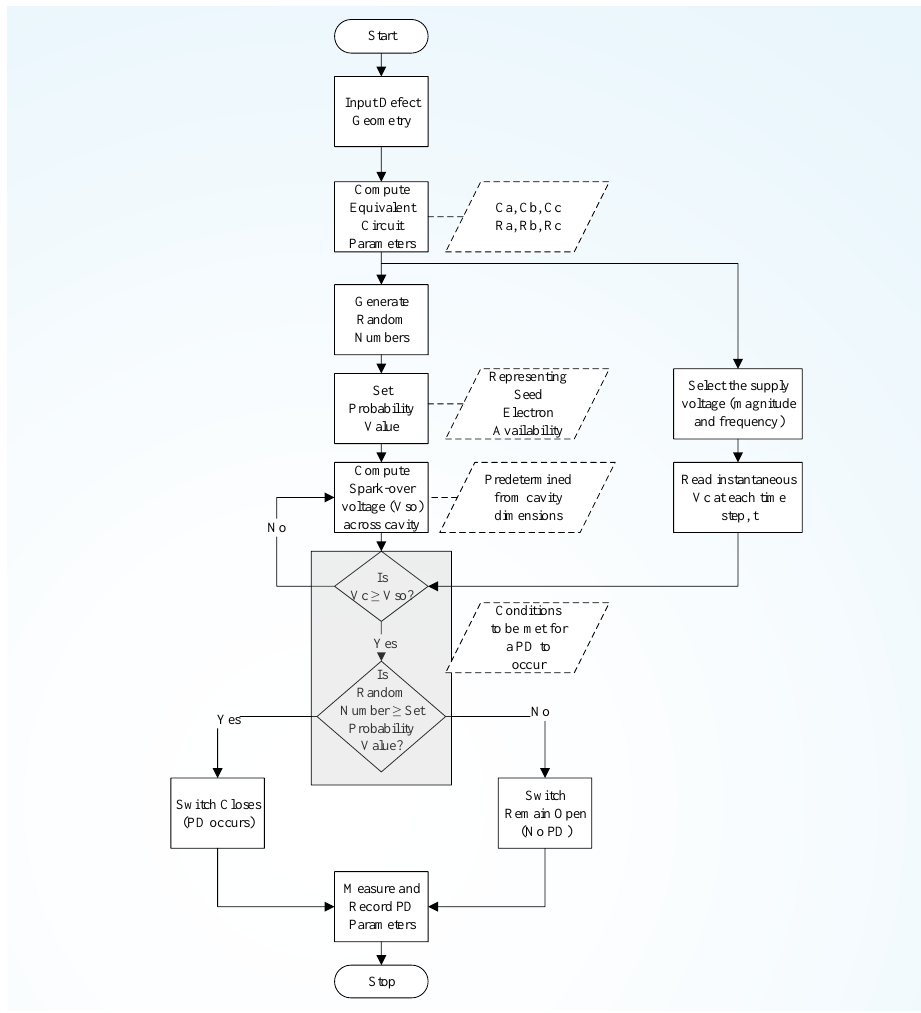
Figure 2. Flow diagram of the implemented PD model